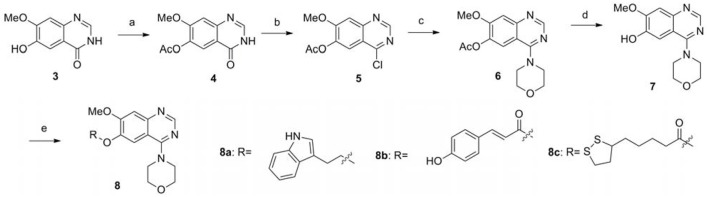
The synthesis route of compounds 8a−8c. Reagents and conditions: (a) Aceticanhydride, pyridine, 100°C, 2 h; (b)SOCl2, DMF, 80°C, 2.5 h; (c) Morpholine, DMF, 80°C, 6 h; (d) Ammonia, methanol, reflux, 2 h; (e) The corresponding bromide, K2CO3, DMF, reflux for 3 h; or the corresponding acid, EDCI, DMAP, DMF, reflux overnight.